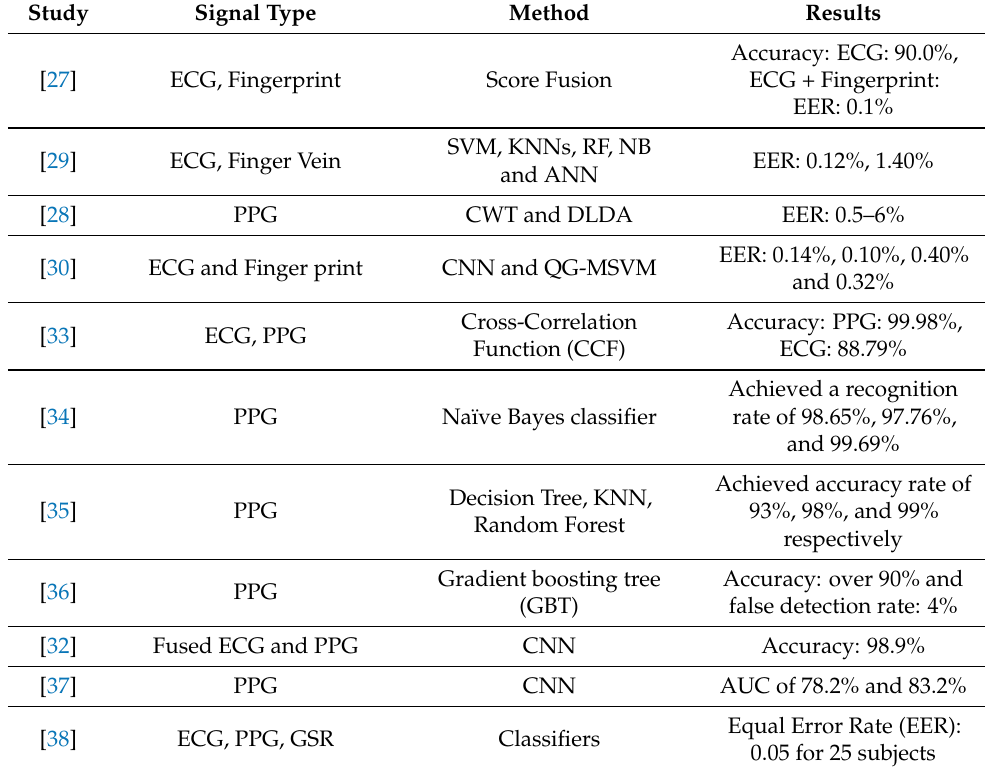
Table 1. Comparisons with other Machine Learning-based Biometric Authentication